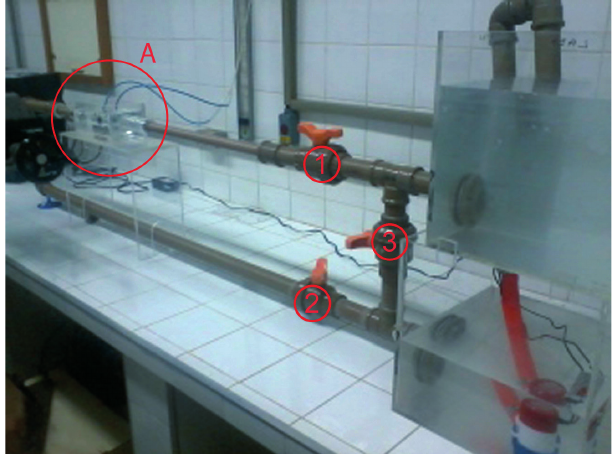
Fig. 1 - Steady flow hydrodynamic workbench photo Highlighted: A (test chamber), 1 (top spherical valve), 2 (bottom spherical valve) and 3 (maintenance spherical valve)